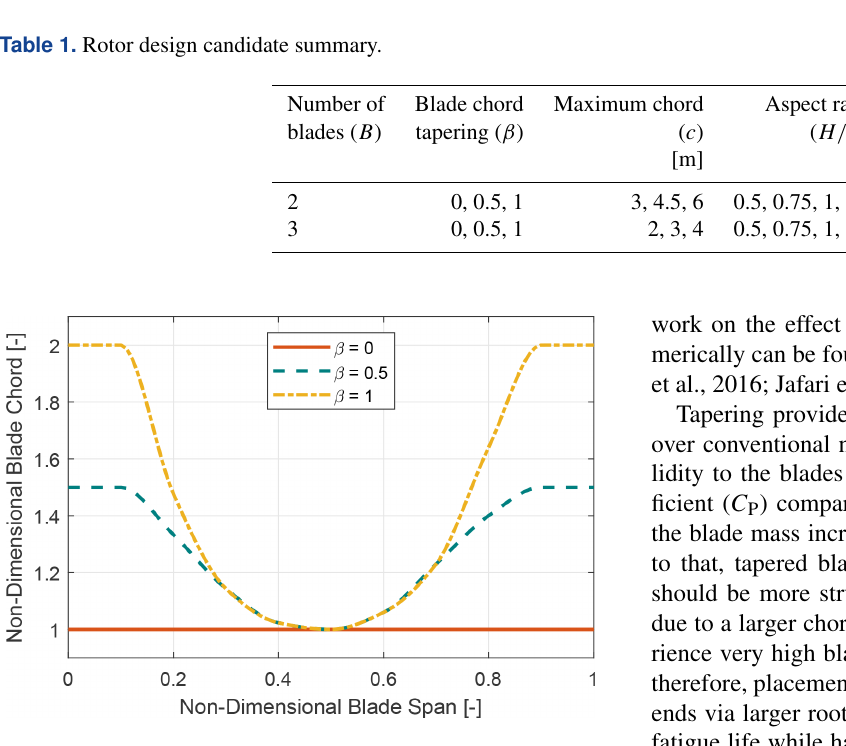
Figure 3. A visual representation of the tapering